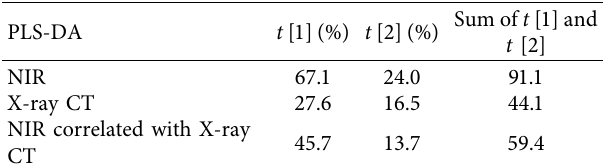
Figure 4: Model based on hyperspectral near-infrared (NIR) surface data and X-ray computed tomography (CT) volume data: (a) knot cluster in black partial least squares discriminant analysis (PLS-DA) scatter plot; (b) contour plot shows knots in a specimen volume; and (c) predicted dead knots. Table 1: Partial least squares discriminant analysis (PLS-DA) models assessing the predictability of the frst and second com- ponents based on three diferent imaged datasets; Near-infrared (NIR), X-ray computed tomography (CT) and NIR correlated with X-ray